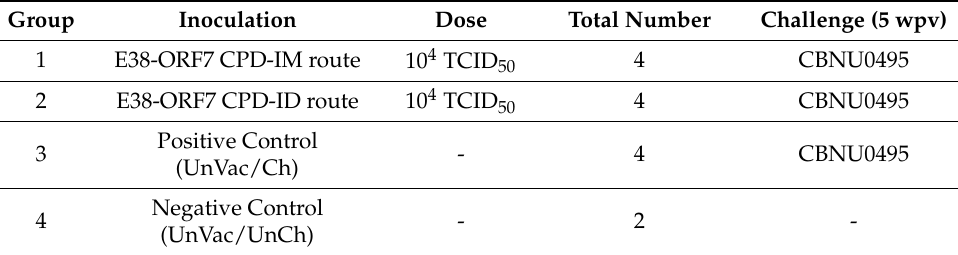
Table 2. Animal experiment to evaluate the protective efficacy of E38-ORF7